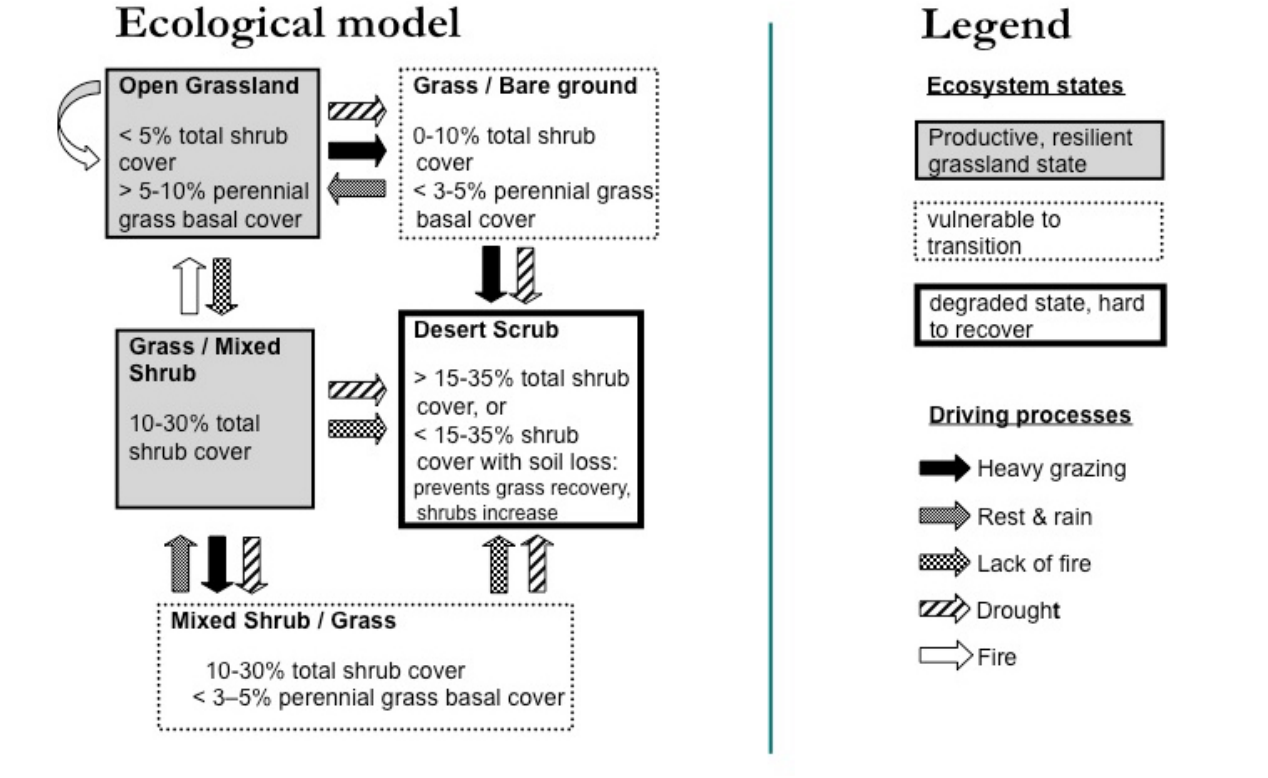
Fig. 4 . A conceptual model of southern Arizona semidesert grasslands. This model is generalized from numerous models developed for specific ecological sites; value ranges reflect differences in thresholds among specific soil types and plant communities. Such models may also be useful during scenario planning as a tool to understand how changing drivers may alter ecosystem